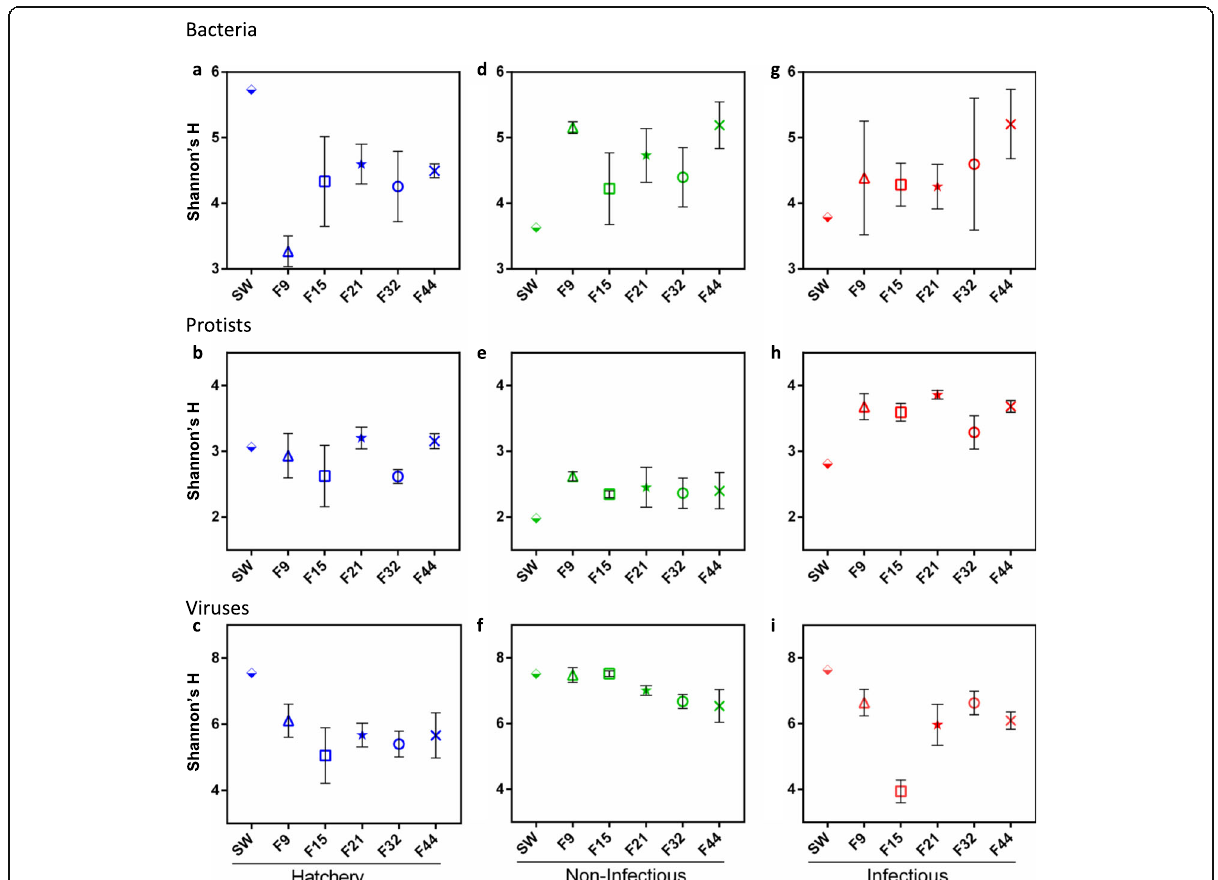
Fig. 3 Alpha diversity expressed as Shannon ’ s H index for bacteria, protists and viruses in the hemolymph and sweater in controlled and natural conditions. a-c) Hatchery, d-f) natural non-infectious and g-i) infectious environment. Bacterial and protistan diversity estimates are based on OTUs, viral on the recovered contigs. The Shannon ’ s H indices of bacterial (a, d, g) , protist (b, e, h) and viral (c, f, i) communities are presented on the same row. Error bars represent standard error of the